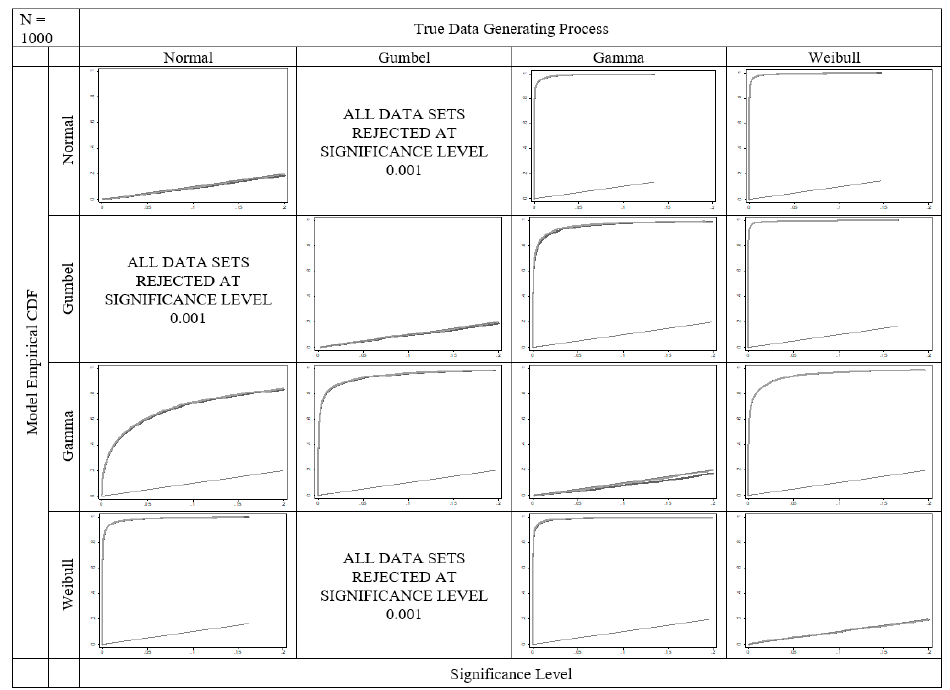
Table 3. Monte Carlo Simulation: Empirical CDFs of Experiments on Distribution Specifications